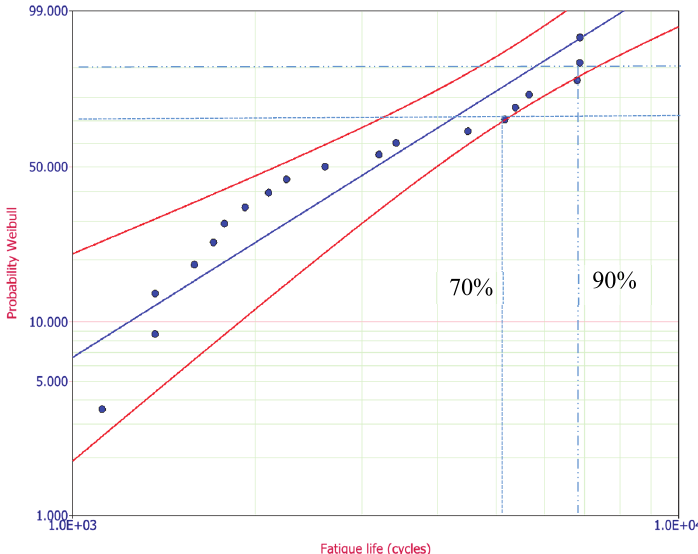
Figure 8: The Weibull probability distribution plots of fatigue damage for